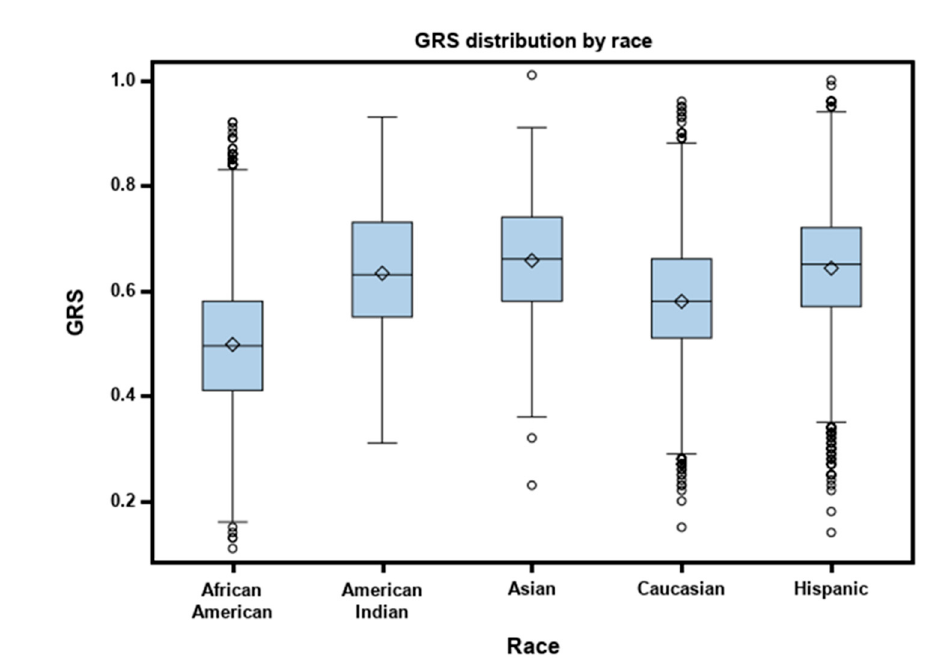
Figure A1. Box plot for the distribution of GRS in di ff erent race groups ( n = 23,981).